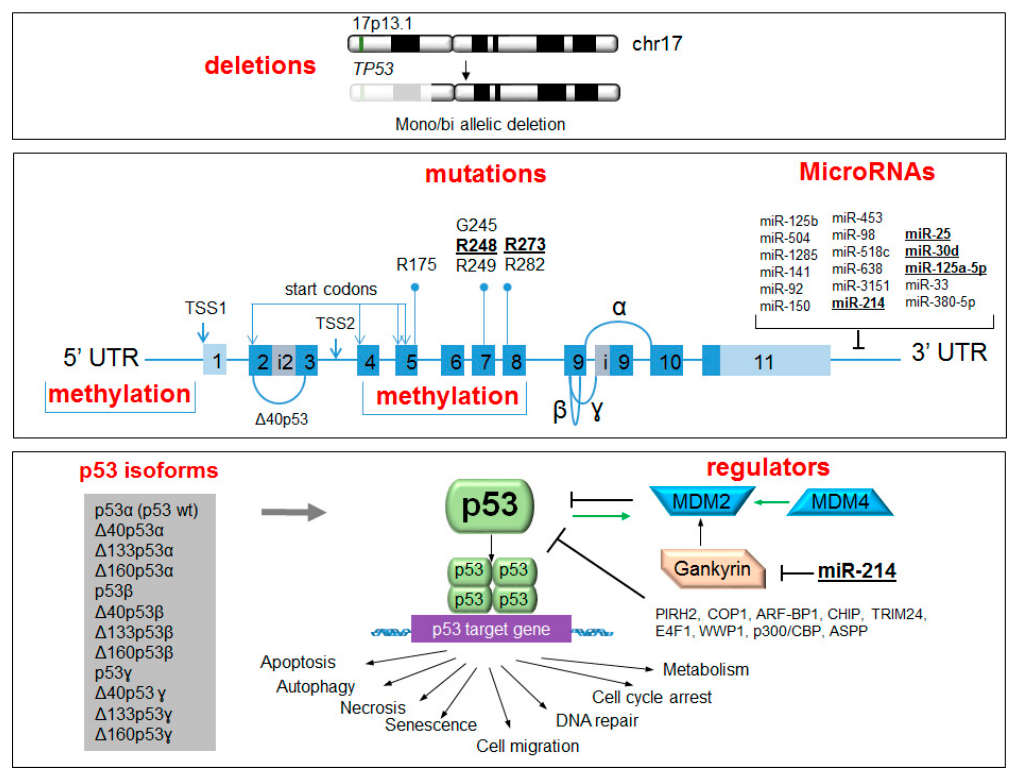
Figure 1. Mechanisms of p53 regulation in cancer. p53 can be attenuated directly, by mutation or deletion, or indirectly through alterations in methylation, miRNAs, isoform expression and p53 regulators. Six TP53 hotspot mutations and regions potentially affected by methylation are indicated. p53 isoforms arise from the use of two alternative transcription start sites (TSS1 and TSS2), four start codons and alternative splicing, which originates the isoforms α , β and γ . miRNAs and regulators reported to affect p53 expression are shown. Alterations reported in MM are highlighted in bold and underlined.